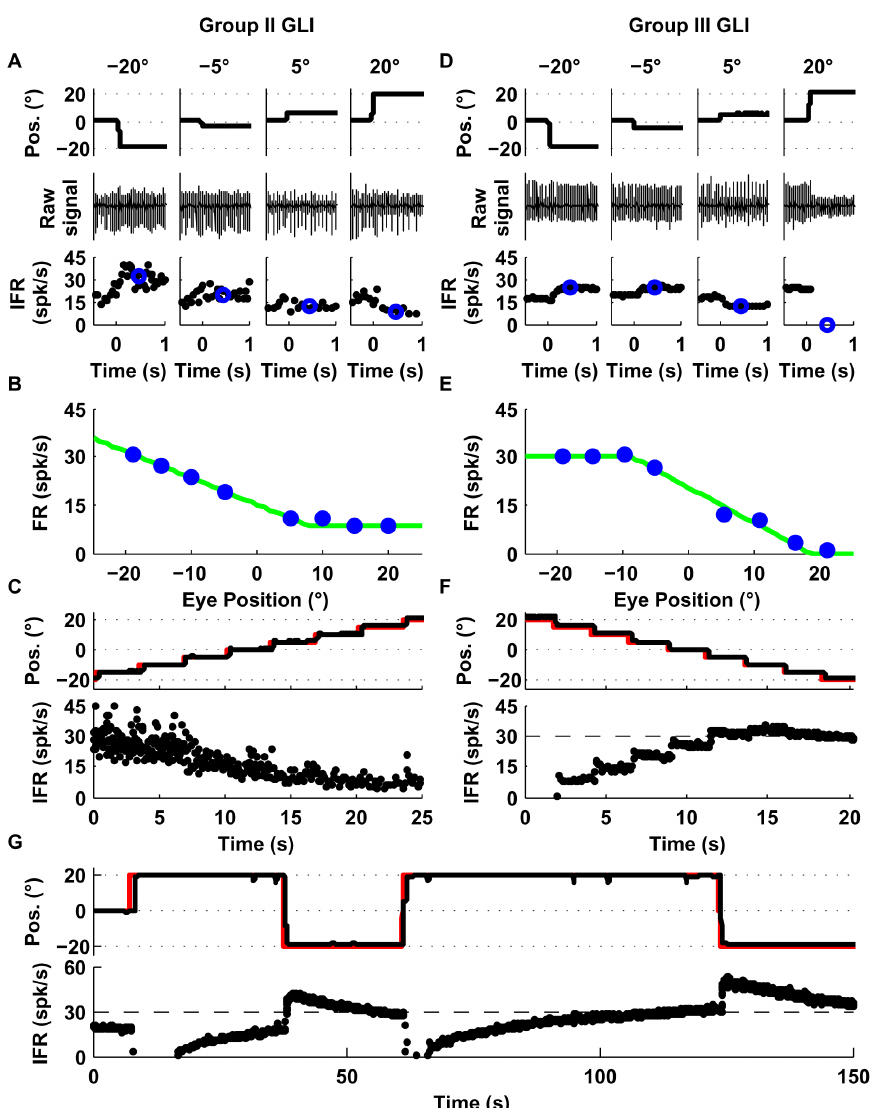
Figure 4. Responses of example Group II (A–C) and III (D-G) GLIs. ( A, D ) The upper row shows horizontal eye position, the middle raw spike data, and the bottom row instantaneous firing rate (IFR). Blue circles in the lower row represent the average firing rate following each saccade (200– 700 ms). ( B, E ) Relationship between average firing rate and eye position using data from trials like those shown in A and D. Both cells were fit with the function F 2 . The corresponding fits are shown as green lines in B and E. ( C, F ) Response of the each example neuron during sequential saccades (5 deg). The upper row shows in black traces the eye position and in red traces the laser position; the lower row shows the instantaneous firing rate (IFR). ( G ) Response of the example Group III GLI shown in D–F during long eye fixations. The upper row shows in black traces the eye position and in red traces the laser position, the lower row shows the instantaneous firing rate